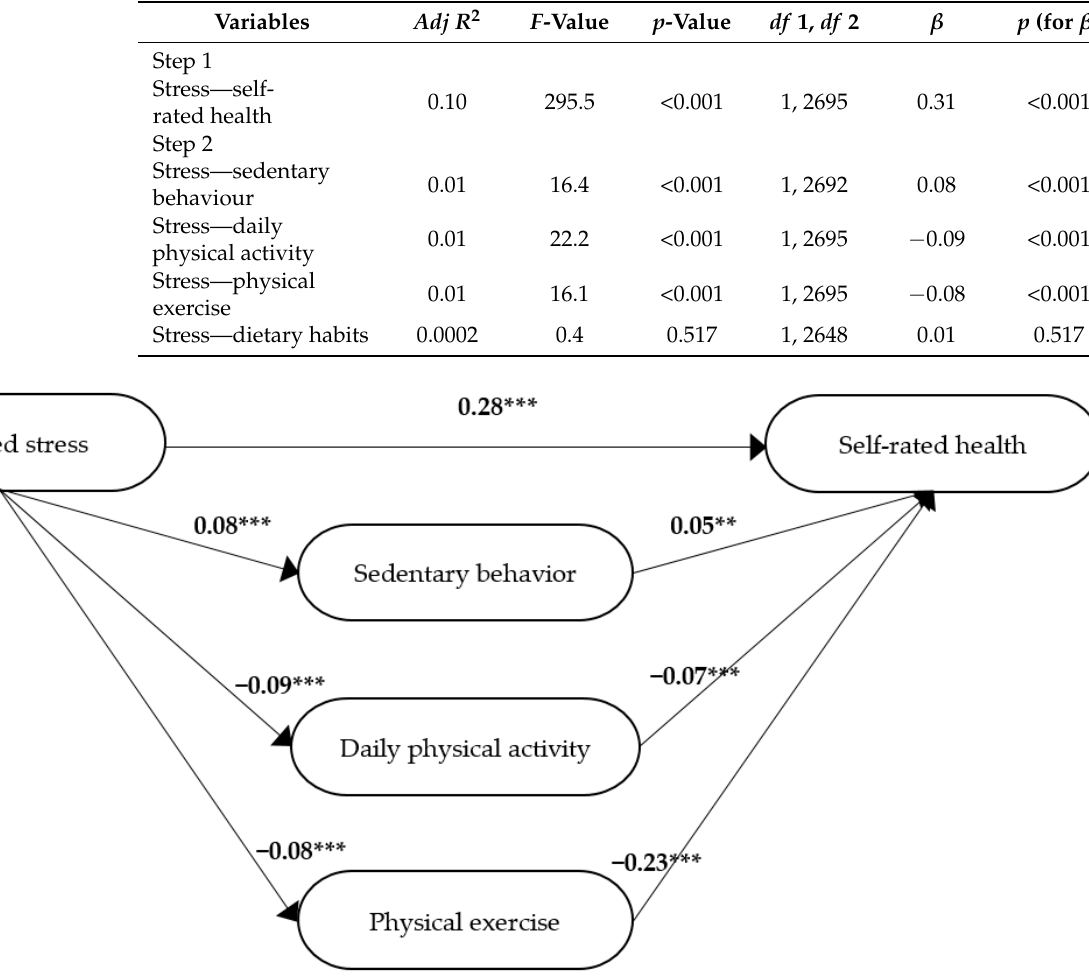
Table 5. Simple regression analyses for participants who reported one of the requested diagnoses (steps 1 and 2).